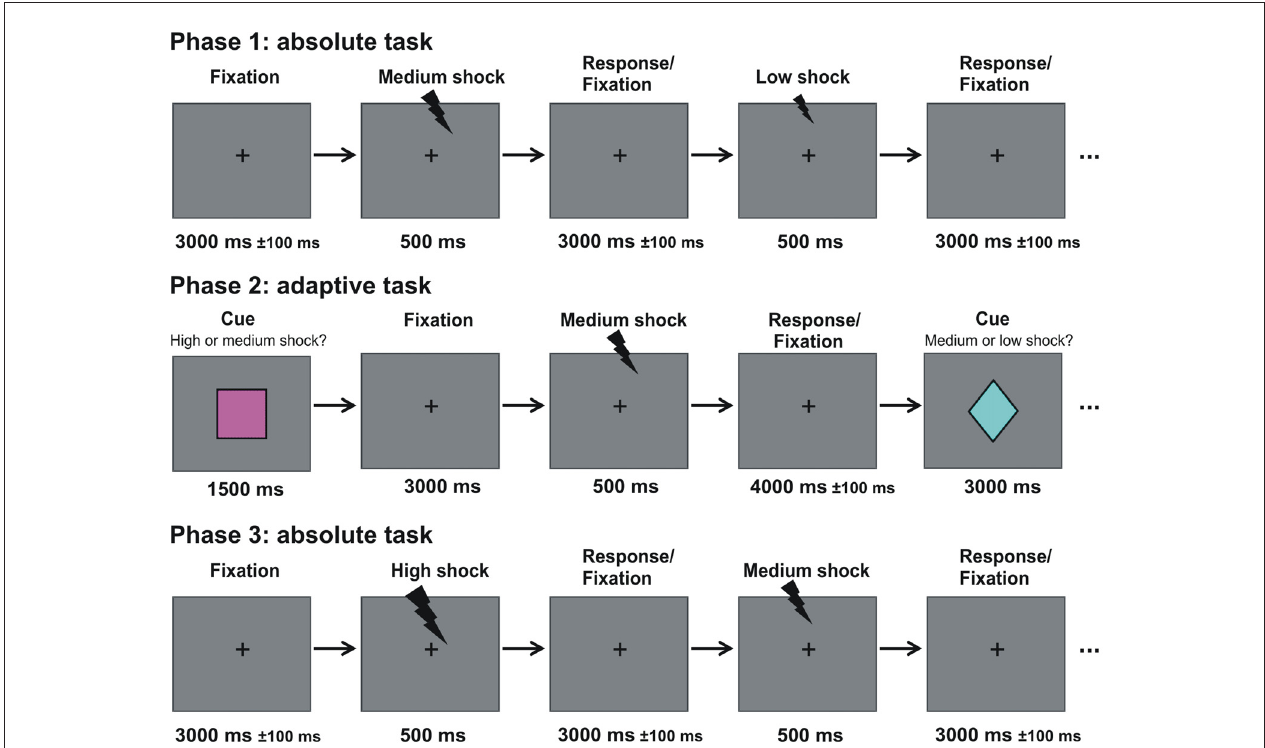
FIGURE 1 | Experimental design. Participants underwent three phases. In the first and third phase (absolute task), electrical stimulation with three different magnitudes were presented randomly intermixed to the back of the hand. Subjects had to make low/medium/high judgments (see experimental procedures for details). In between both phases, participants took part in the adaptive task, where they learned the association between three contexts and three visual cues that predicted with 50% probability either: (1) a high or a medium stimulation; (2) a medium or a low stimulation; or (3) a high or a low stimulation. Participants made a relative low/high judgment (see experimental procedures for